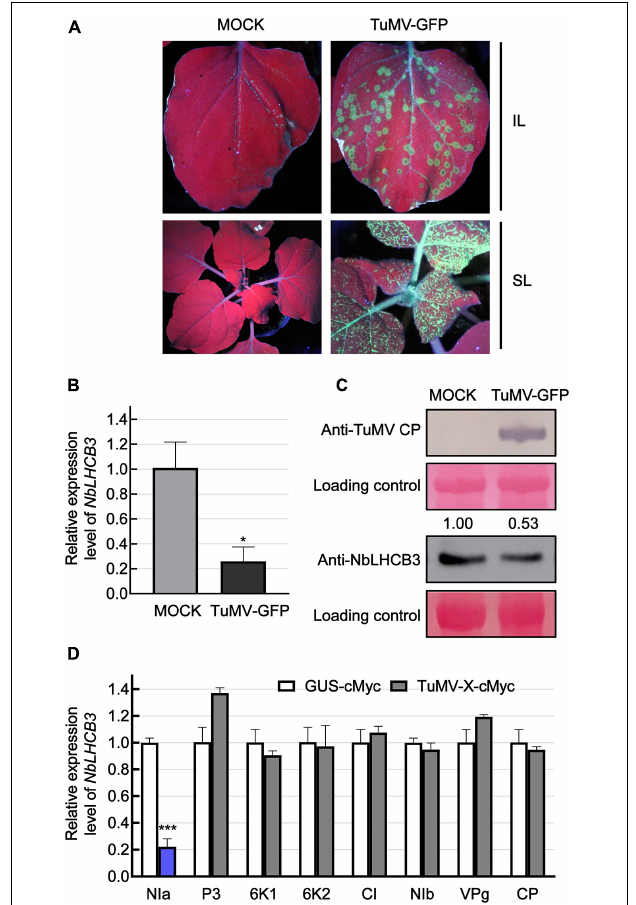
FIGURE 1 | Expression of NbLHCB3 was downregulated in N. benthamiana infected with TuMV-GFP. (A) Fluorescence under UV showing TuMV-GFP infection on inoculated leaves (IL) and systemically infected leaves (SL). Leaves of 2-week-old plants were mechanically inoculated with an extract of TuMV-GFP-infected leaves. Phosphate buffer was used as mock control. Pictures were captured at 4 dpi under UV. (B) qRT-PCR showing the transcript levels of NbLHCB3 in the inoculated leaves of three mock and three TuMV-GFP-infected N. benthamiana plants at 4 dpi. Experiments were repeated three times. (C) Western blot analysis showing TuMV CP and NbLHCB3 accumulation on the systemically infected leaves of TuMV-GFP-infected plants at 4 dpi. The relative intensity of the blot signal quantified by IMAGE J software is shown on the lanes. (D) Results of qRT-PCR showing NbLHCB3 expression in zones from four leaves of four plants expressing different cMyc-fused TuMV proteins. cMyc-fused beta-glucuronidase protein (GUS-cMyc) was used as control. Bars represent the standard errors of the means from three biological repeats. A two-sample unequal variance directional Student’s t -test was used to test the significance of the differences (* P < 0.05; *** P <